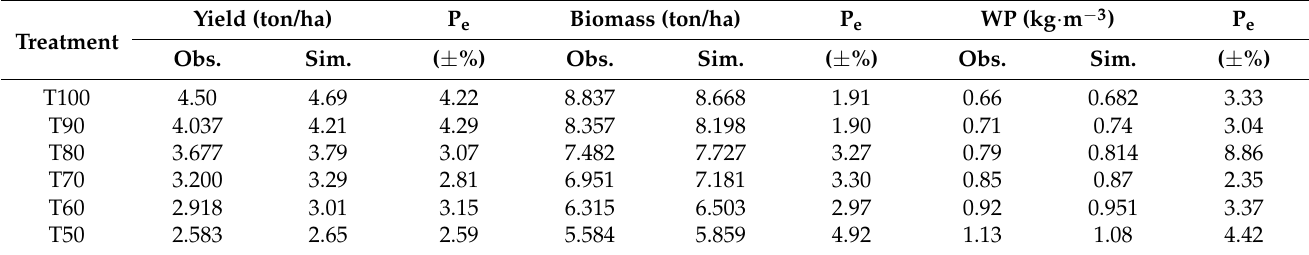
Table 6. The results of model calibration for grain yield, biomass, and water use efficiency for the winter wheat crop under different irrigation conditions